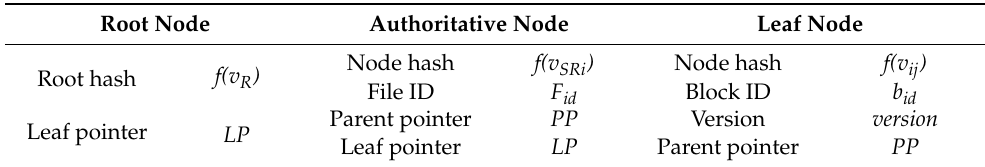
Table 2. The node attributes at different